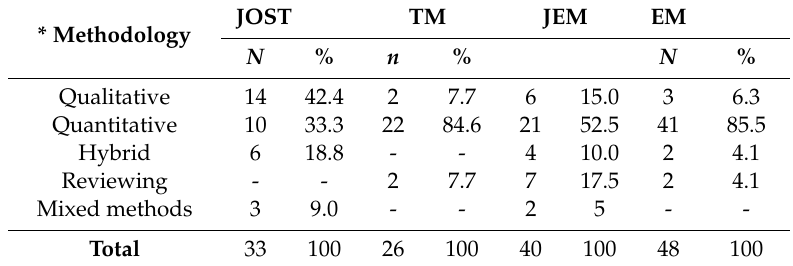
Table 5. Methodologies applied in recreational ecology papers (JOST, TM, JEM, EM, 1976–2017). JOST TM * Methodology